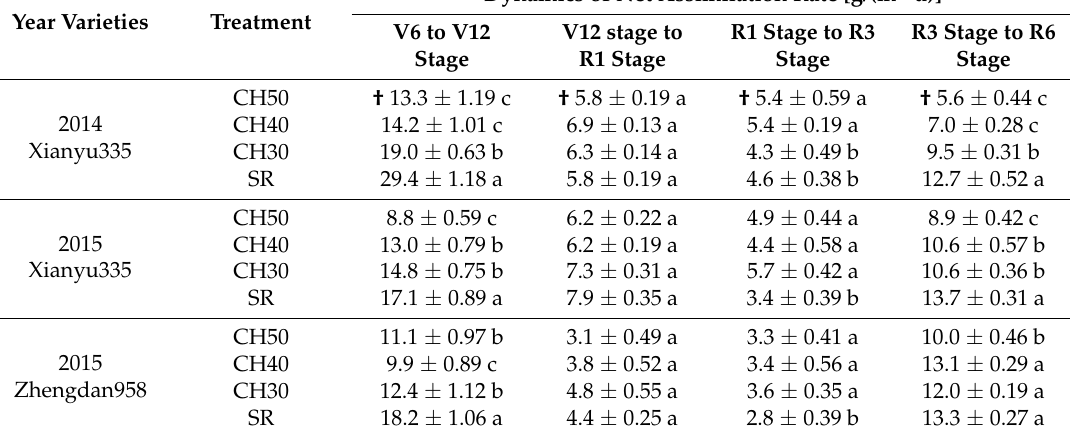
Table 4. Dynamics of net assimilation rate between plant stages when grown under different chiseling depths. Values are the mean of three replications ± 1 standard